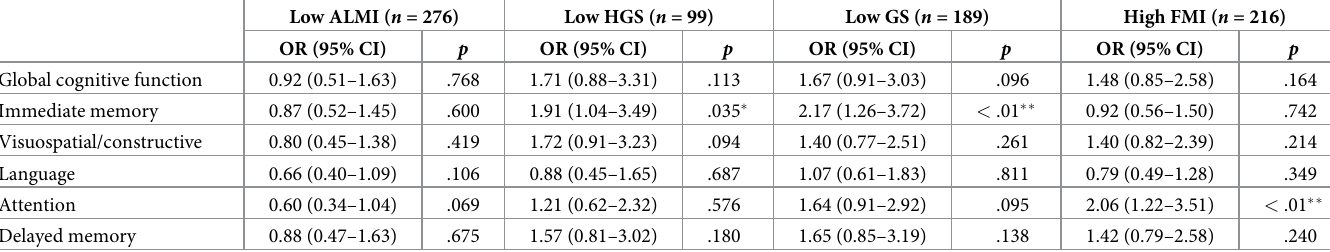
Table 3. Association between components of sarcopenic obesity and risk of impairment in different domains of cognitive